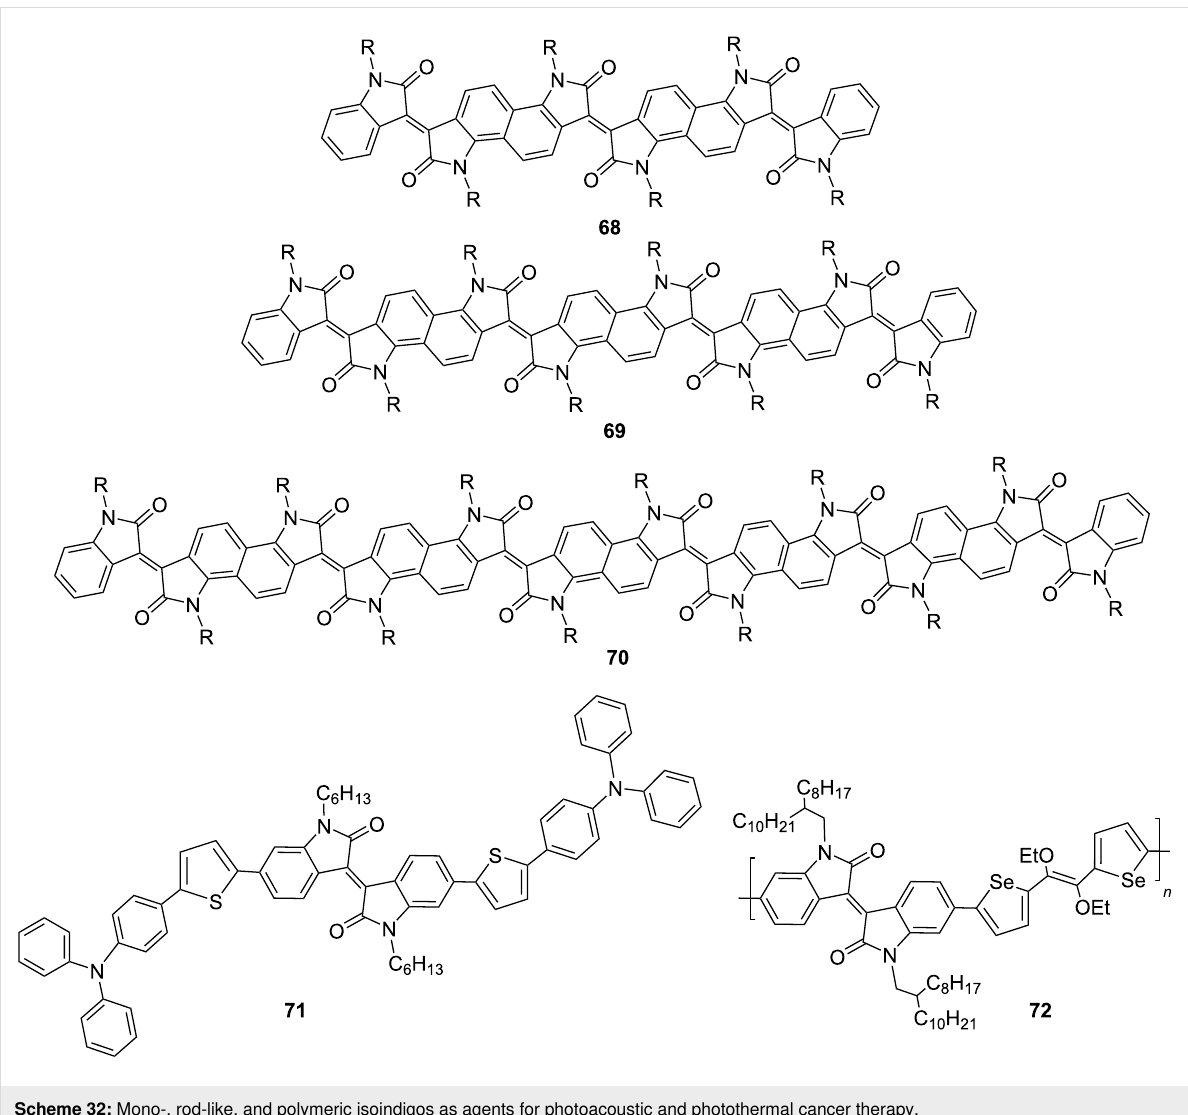
Scheme 32: Mono-, rod-like, and polymeric isoindigos as agents for photoacoustic and photothermal cancer therapy.